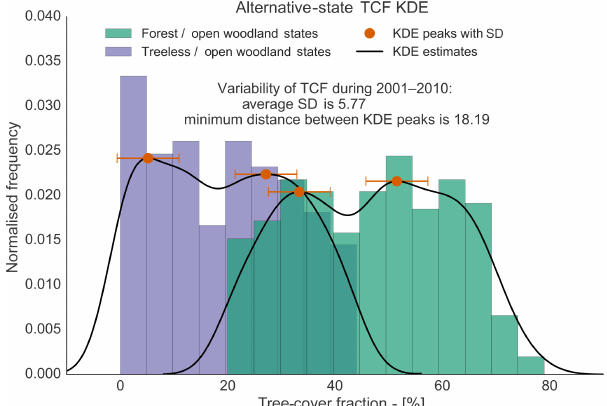
Figure 5. The histogram shows the tree-cover fraction distributions of the possible alternative tree-cover states compared with tree- cover fraction internal variability. Purple bars refer to treeless/open woodland states, and green to forest/open woodland states. The black lines and the orange dots represent the kernel density estimate fittings of these distributions and the locations of their modal peaks, respectively. Internal variability of the tree-cover fraction distribu- tion for the period 2001–2010, computed as the standard deviation of the distribution, is 5.77 percentage points, and is represented as the orange error-bars. The minimum distance between peaks cor- responding to different vegetation states is 18.19 percentage points and is higher than what internal variability could